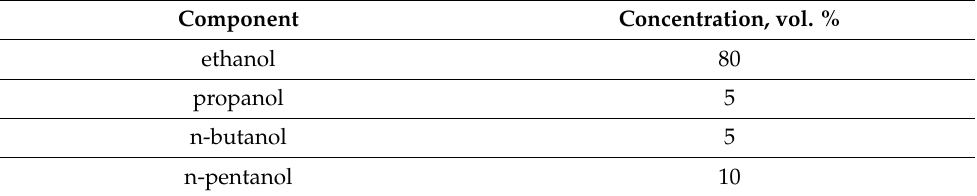
Table 11. Component composition of the products of enzymatic fermentation of corn [42].